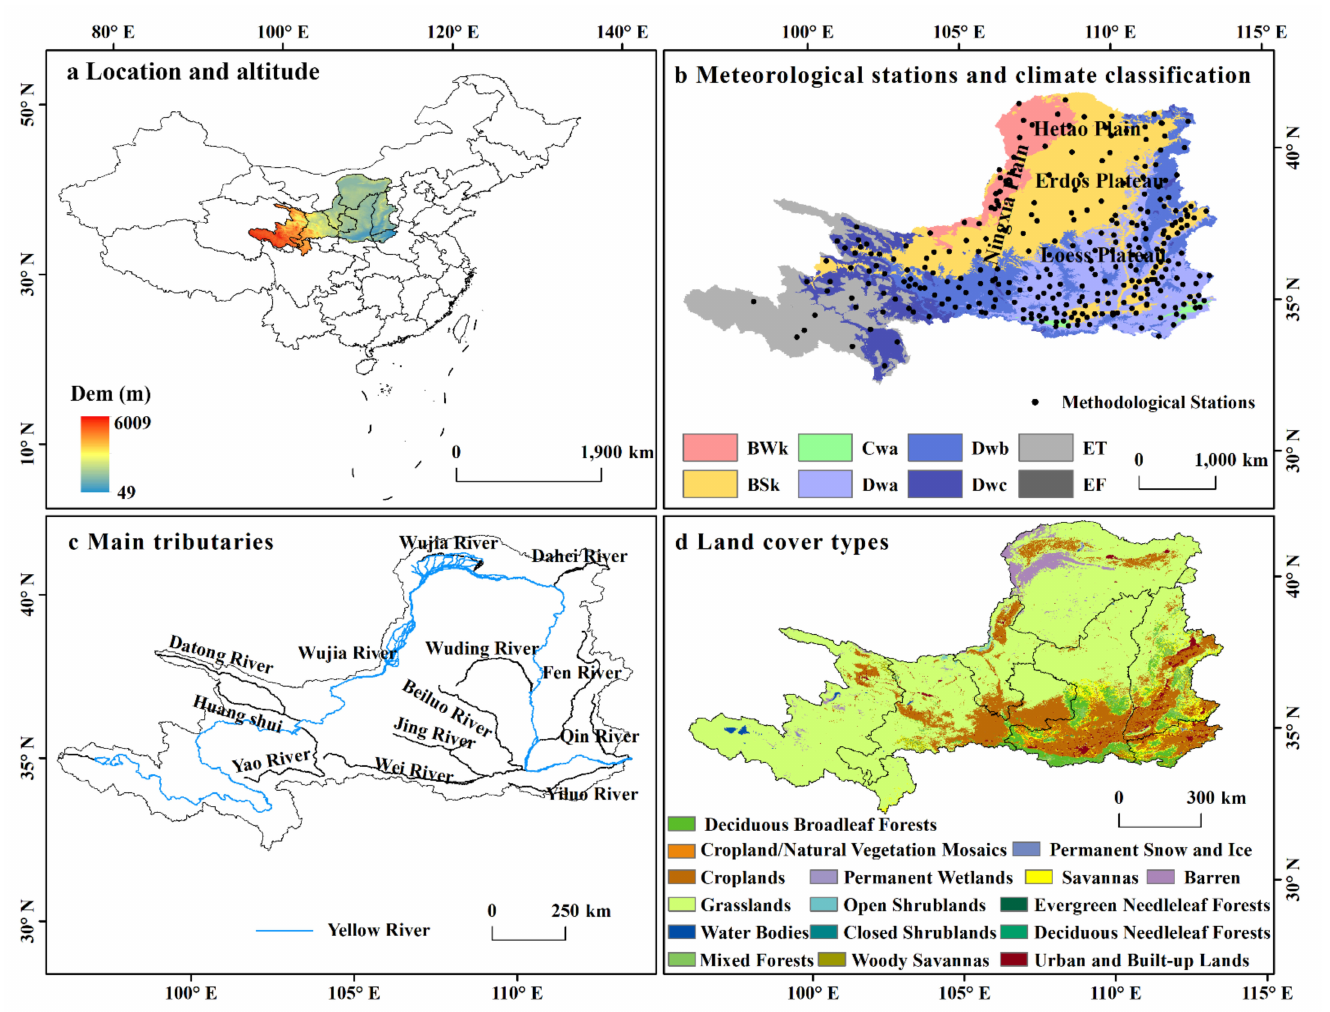
Figure 1. Location and altitude ( a ), stations and climate classification (BWk: cold desert; BSk: cold steppe climate; Cwa: dry-winter humid subtropical climate; Dwa: hot-summer continental climate; Dwb: warm-summer continental climate; Dwc: boreal climate; ET: tundra climate; EF: ice-cap climate) ( b ), main tributaries ( c ), and land cover types in 2019 ( d ) of the upper and middle reaches of the Yellow River